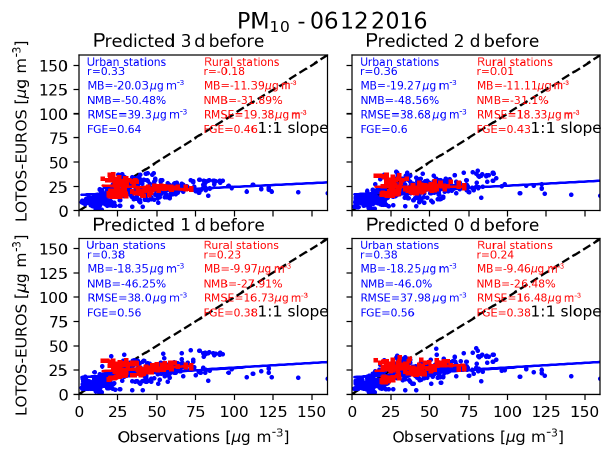
Figure 4. As Fig. 3 for LOTOS-EUROS.